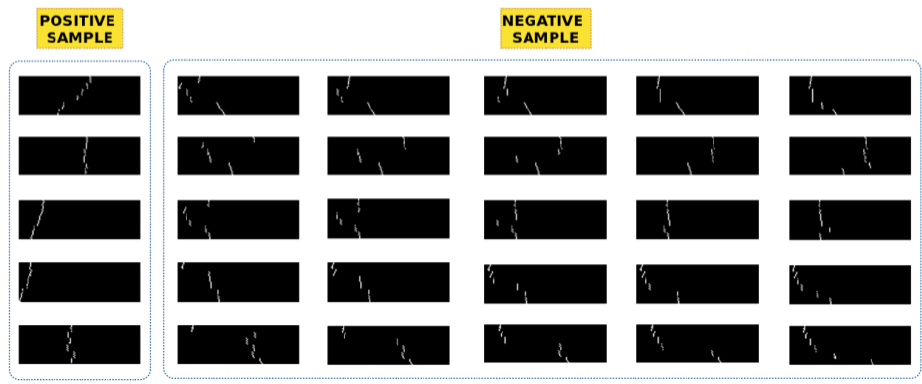
Figure 5. Some representatives of both the positive and negative